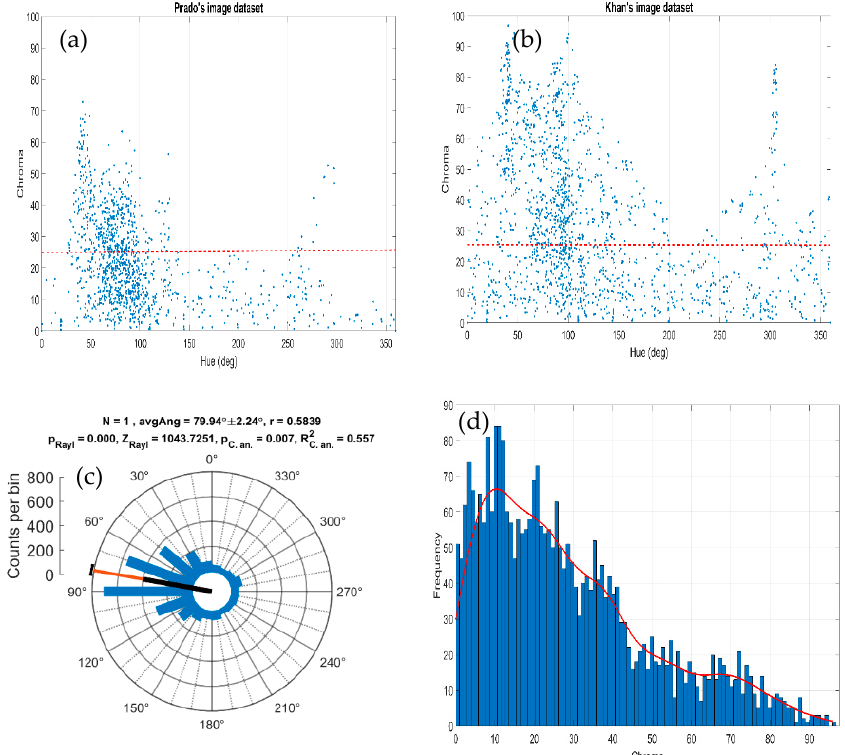
Figure 8. ( a , b ) Hue versus chroma colour components derived from the subjective relevant colours for all observers. ( c ) Polar histogram of the frequency distribution of the hue and ( d ) chroma colour components obtained for both sets of paintings and all